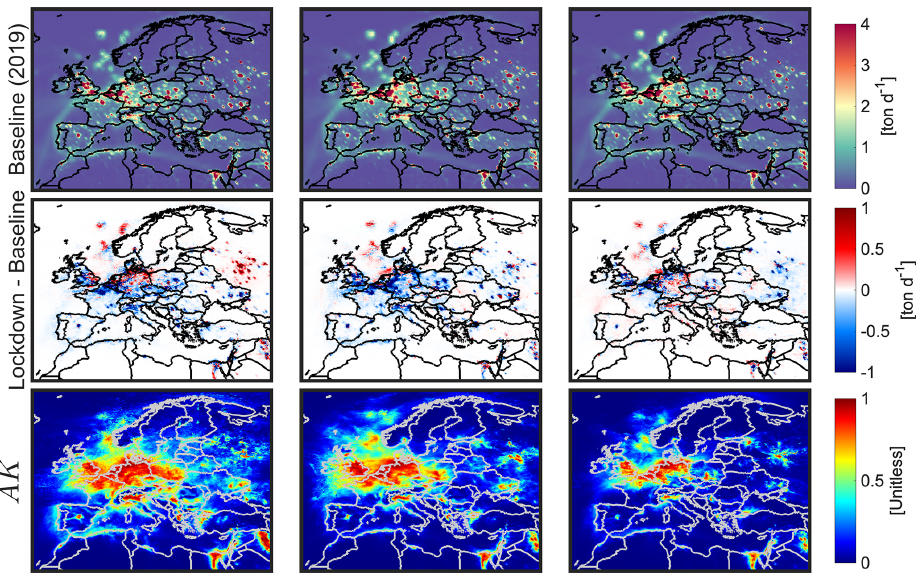
Figure 3. Top-down estimates of total NO x during months of March, April, and May in 2019 (baseline) and the differences between emission in 2020 (lockdown) and 2019. To infer the magnitude of emissions in 2020, the second row should be added to the first one. Both TROPOMI HCHO and NO 2 observations are jointly used to estimate these numbers. Averaging kernels (mean values based on both 2019 and 2020 estimates) describe the level of credibility of the estimate which is heavily dependent on the TROPOMI signal-to-noise ratios.